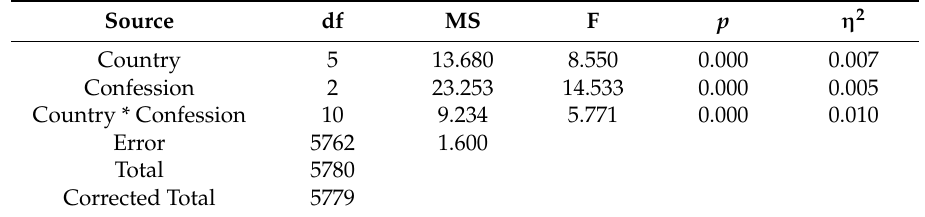
Table A13. Country and confession on using connections for getting things done. Source